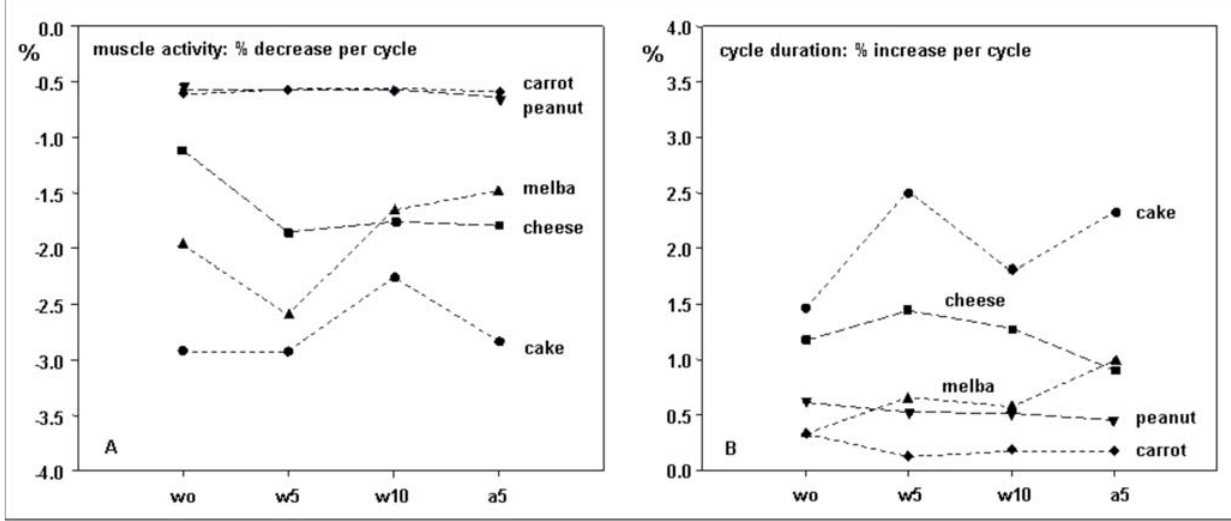
FIGURE 2- Percentage decrease in muscle activity and cycle duration per cycle during chewing for the different foods and fluids. wo: without fluid; w5: 5 mL water; w10: 10 mL water; a5: 5 mL α -amylase solution